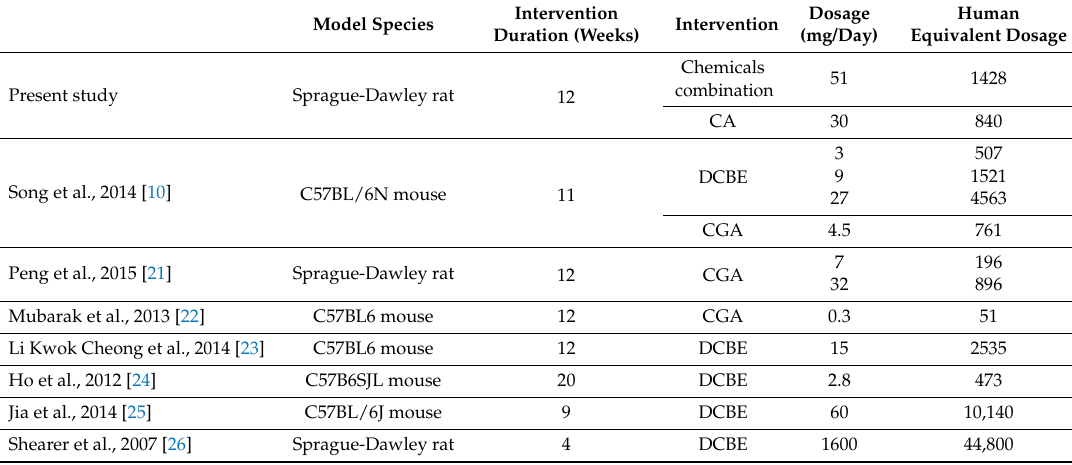
Table 2. A comparison of intervention dosage and duration of the present study and selected published studies on hydroxycinnamic acids and/or decaffeinated coffee extract. Human equivalent dosage enables the comparison between different species used in different studies. For the present study, the dosage of both caffeic acid and total compounds are presented to facilitate the comparison. Model